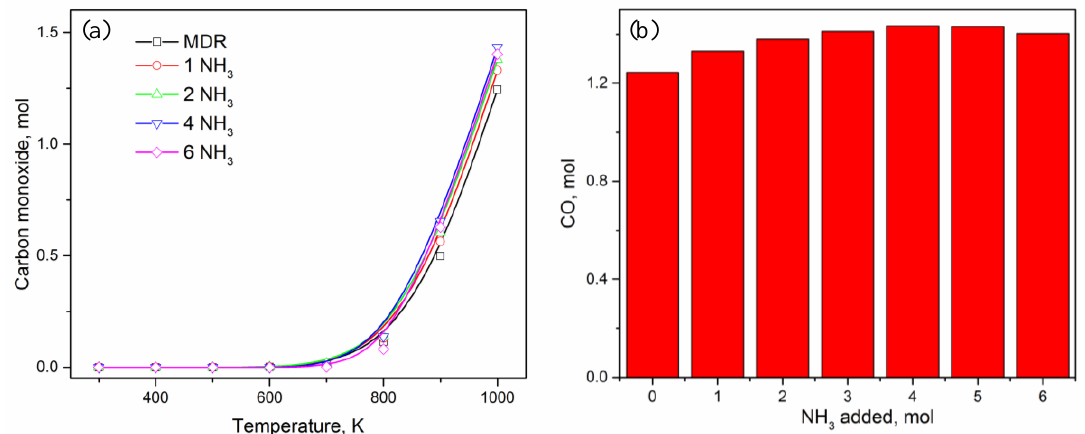
Figure 6. ( a ) Effect of ammonia content in DMR on CO in product; ( b ) CO amount in presence of NH 3 at 1000 K.